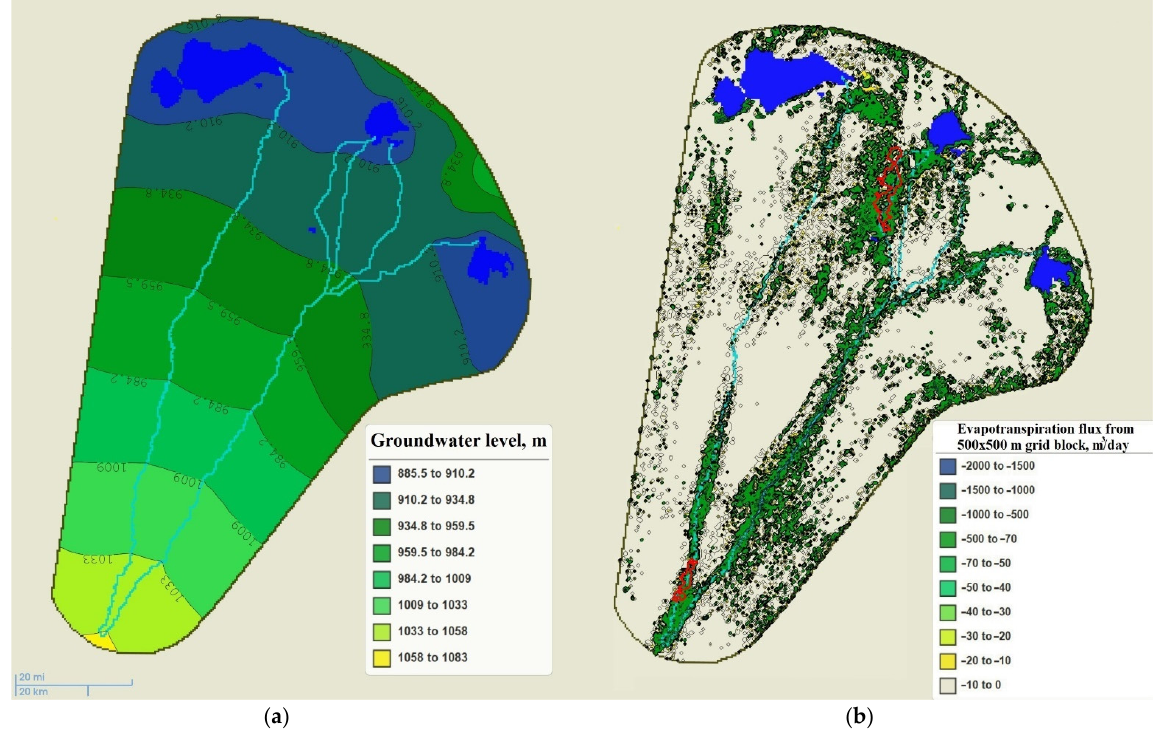
Figure 14. Simulated groundwater levels ( a ) and evapotranspiration discharge ( b ) for July 2017 from a model composed of 500 m × 500 m grid blocks. The red contours represent the areas used to compare the simulated evapotranspiration with the calculated evapotranspiration using remote sensing observations.